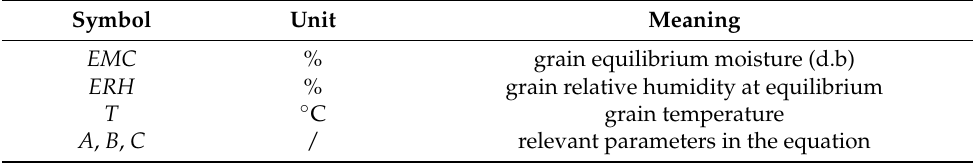
Table 3. Formula (3) symbols and meanings.